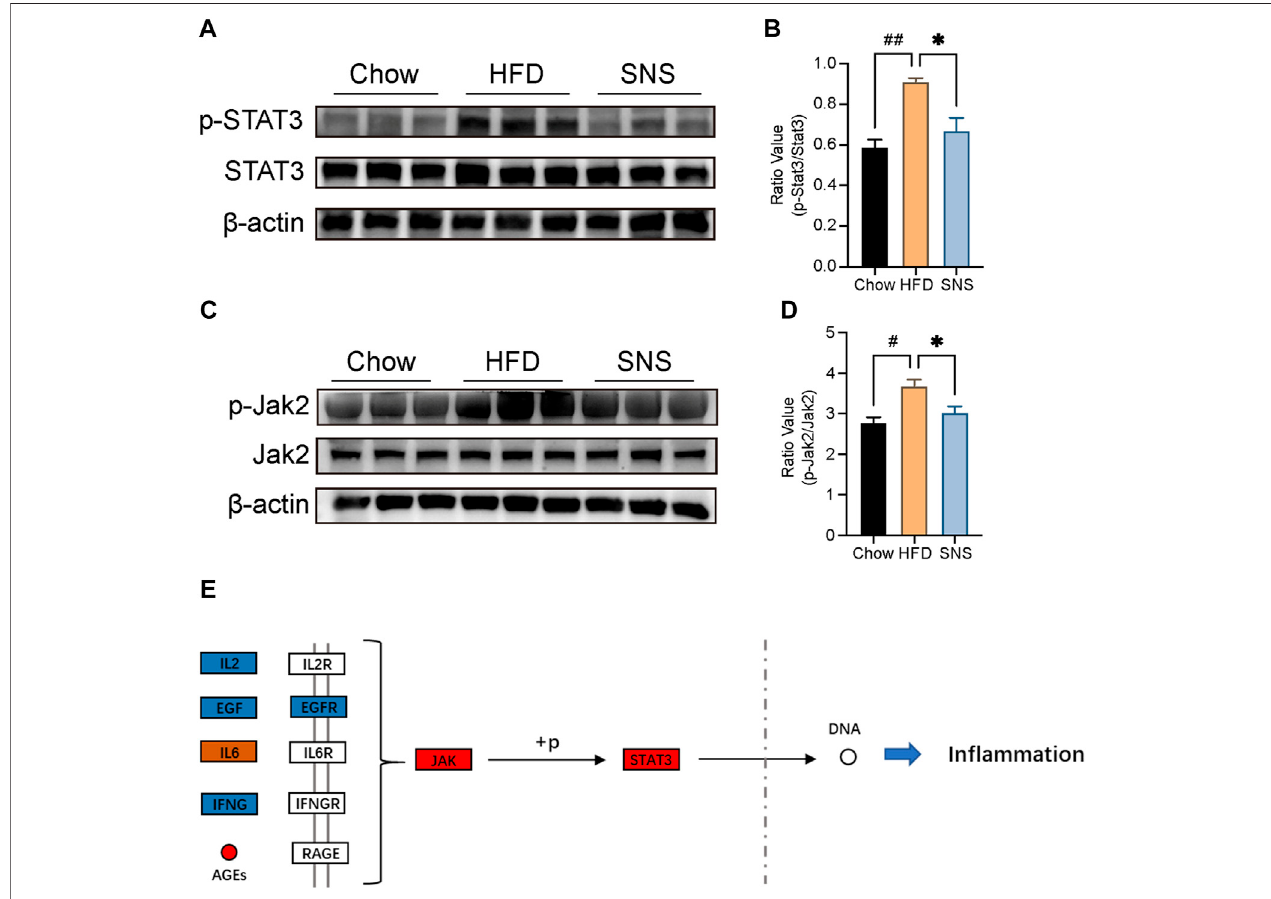
FIGURE 9 | SNS inhibited JAK2/STAT3 signal against NAFLD. (A) Expressions of signal transducer and activator of transcription (STAT3) and phosphorylated STAT3 (p-STAT3) were determined by Western blotting. (B) Quantitative analysis of p-STAT3:STAT3 expression ratio. (C) Expressions of Janus Kinase 2 (JAK2) and phosphorylated JAK2 ( p -JAK2) were determined by Western blotting. (D) Quantitative analysis of p -JAK2:JAK2 expression ratio. Data are shown as mean ± SD (n (cid:2) 3). # p < 0.05, ## p < 0.01, ### p < 0.001 when compared with the Chow group, * p < 0.05, ** p < 0.01, *** p < 0.001 when compared with HFD group.